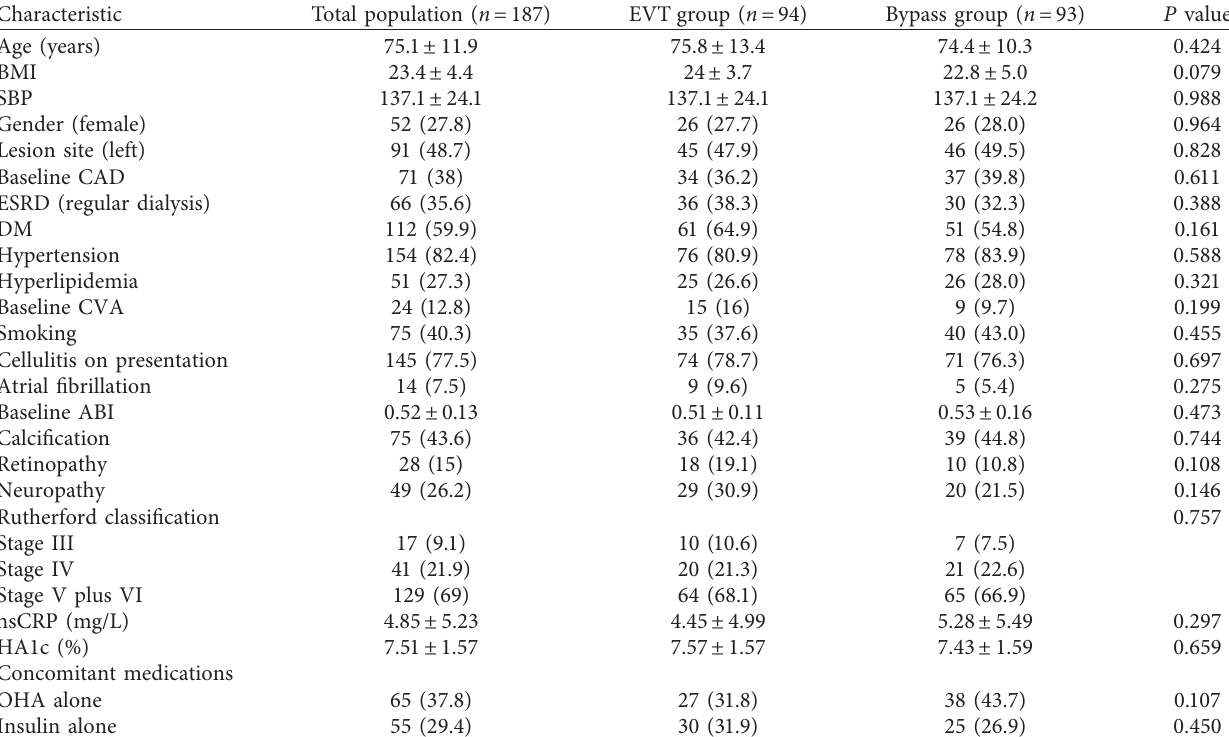
Table 1: Baseline demographics and characteristics associated with